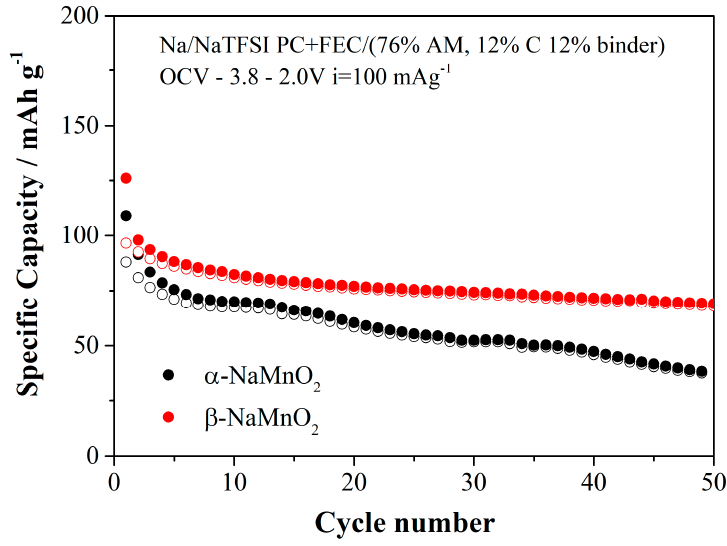
Figure 8. Performance in galvanostatic cycling of the two polymorphs.